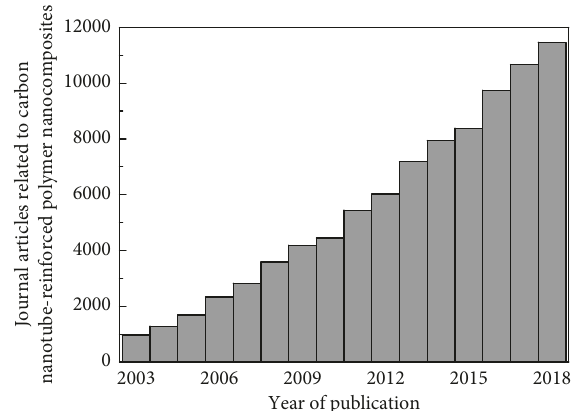
Figure 2: Refereed journal articles published in English related to carbon nanotube-reinforced polymer nanocomposites. Data col- lected from Web of Science by the end of